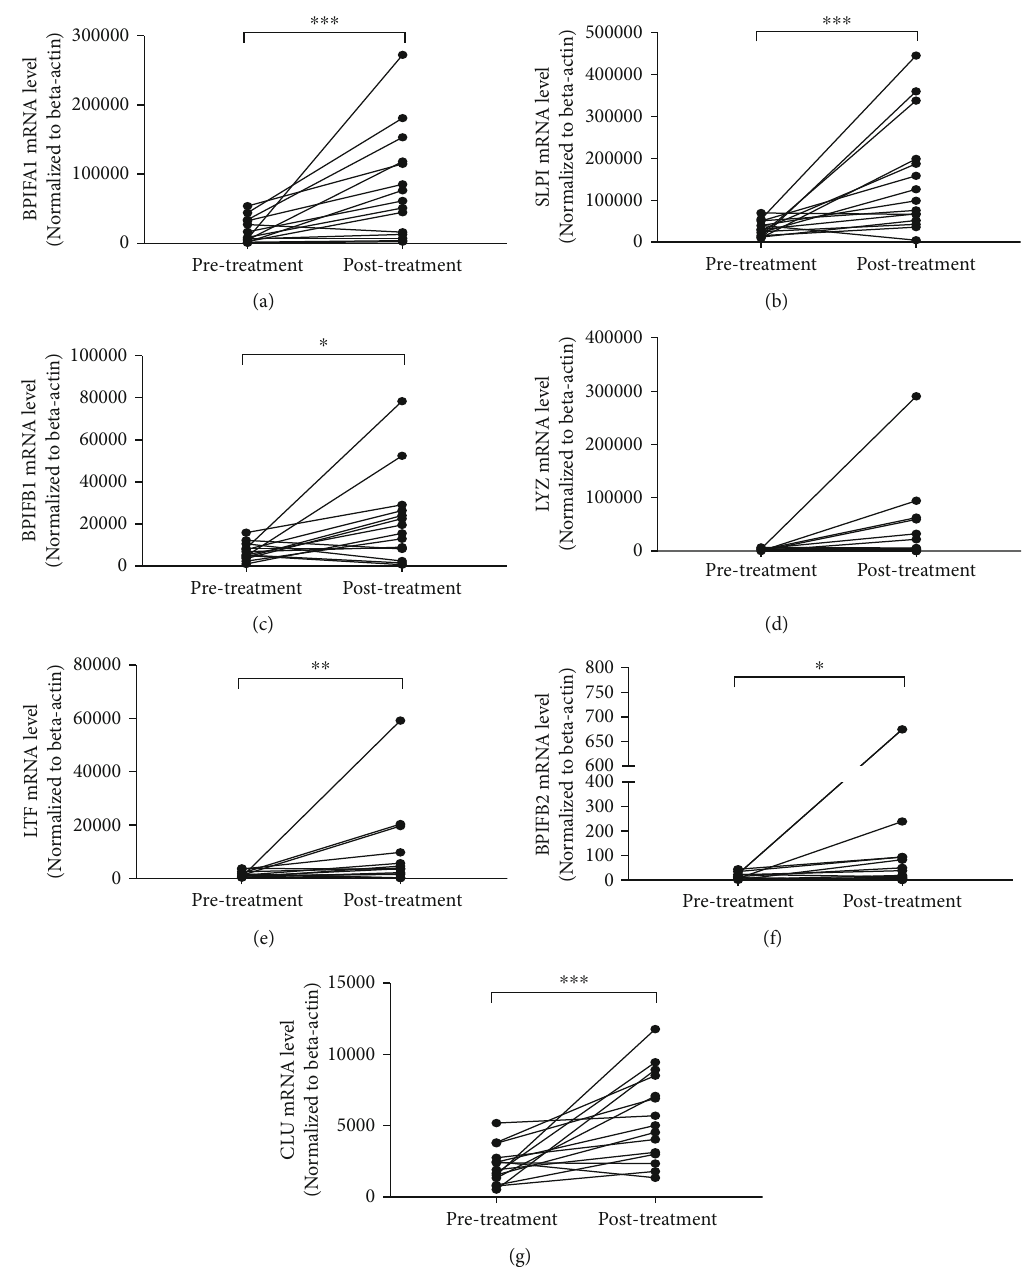
Figure 4: The expression of AMPs in nasal tissues of CRSwNP in response to glucocorticoid treatment. Patients with CRSwNP were treated with 2-week oral glucocorticoid. The expression of AMPs (BPIFA1, SLPI, BPIFB1, LYZ, LTF, BPIFB2, and CLU) was detected in nasal polyp tissues before and after glucocorticoid treatment by real-time PCR. ∗ P < 0 : 05 , ∗∗ P < 0 : 01 , and ∗∗∗ P < 0 : 001 . AMPs: antimicrobial peptides and proteins; CRSwNP: chronic rhinosinusitis with nasal polyps; BPIFA: BPI fold-containing family A member; BPIFB: BPI fold-containing family B member; CLU: clusterin; LTF: lactoferrin; LYZ: lysozyme; SLPI: secretory leukoprotease